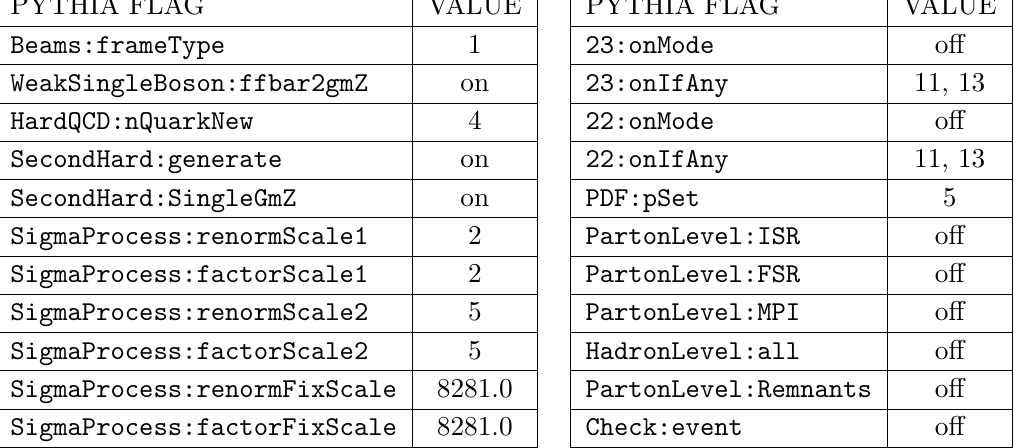
Table 14 . P YTHIA settings we